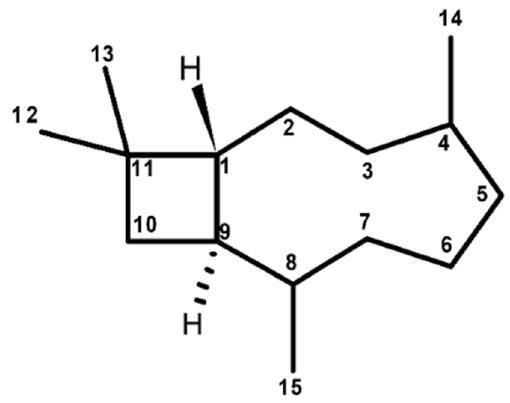
Figure 2. Chemical structures of caryophyllane skeleton.